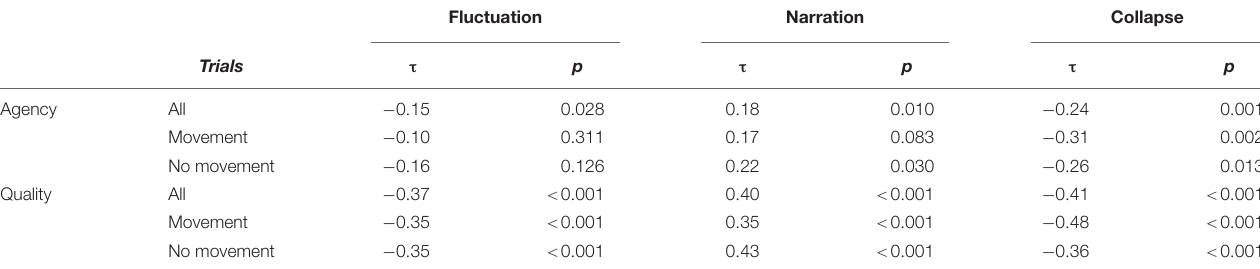
TABLE 2 | Performance error correlations with subjective performance